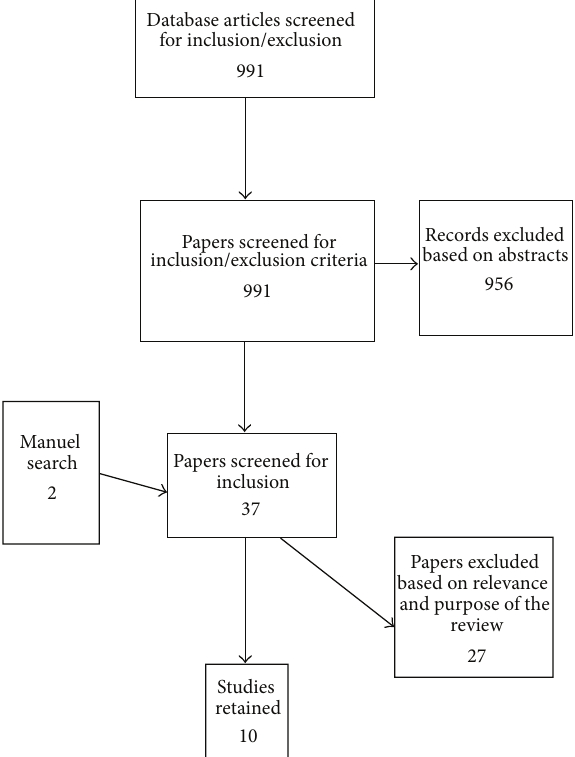
Figure 1: Search and retrieval